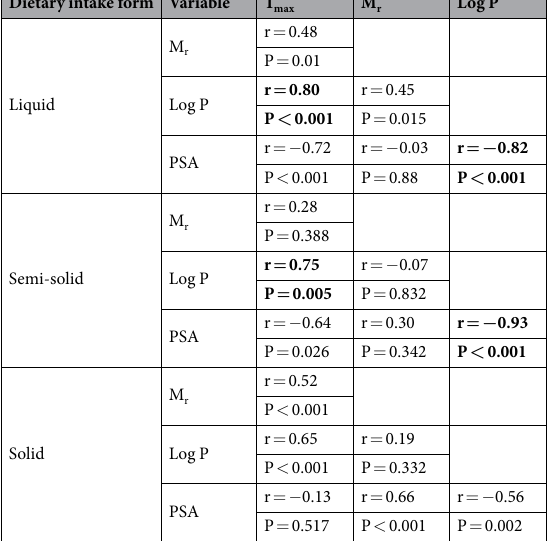
Fig. 2. Log P was relatively evenly distributed across the range from − 4.7–3 and 8.7–10 (Fig. 2a). Therefore, the